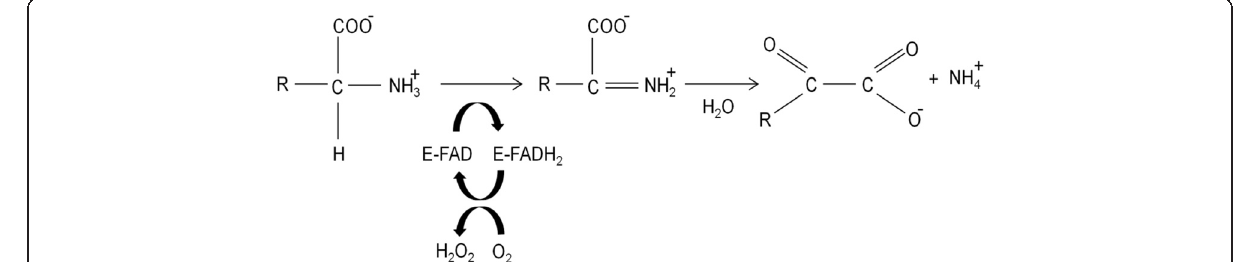
Figure 1 Representation of the reaction catalyzed by L-amino acid